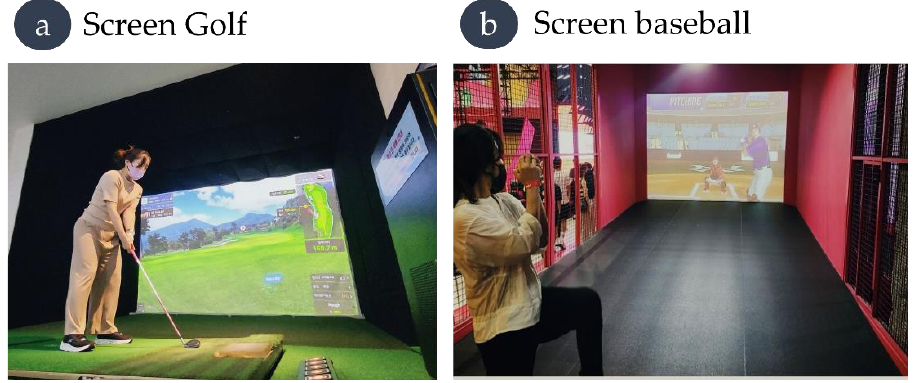
Figure 3. Practical physical education in augmented reality.